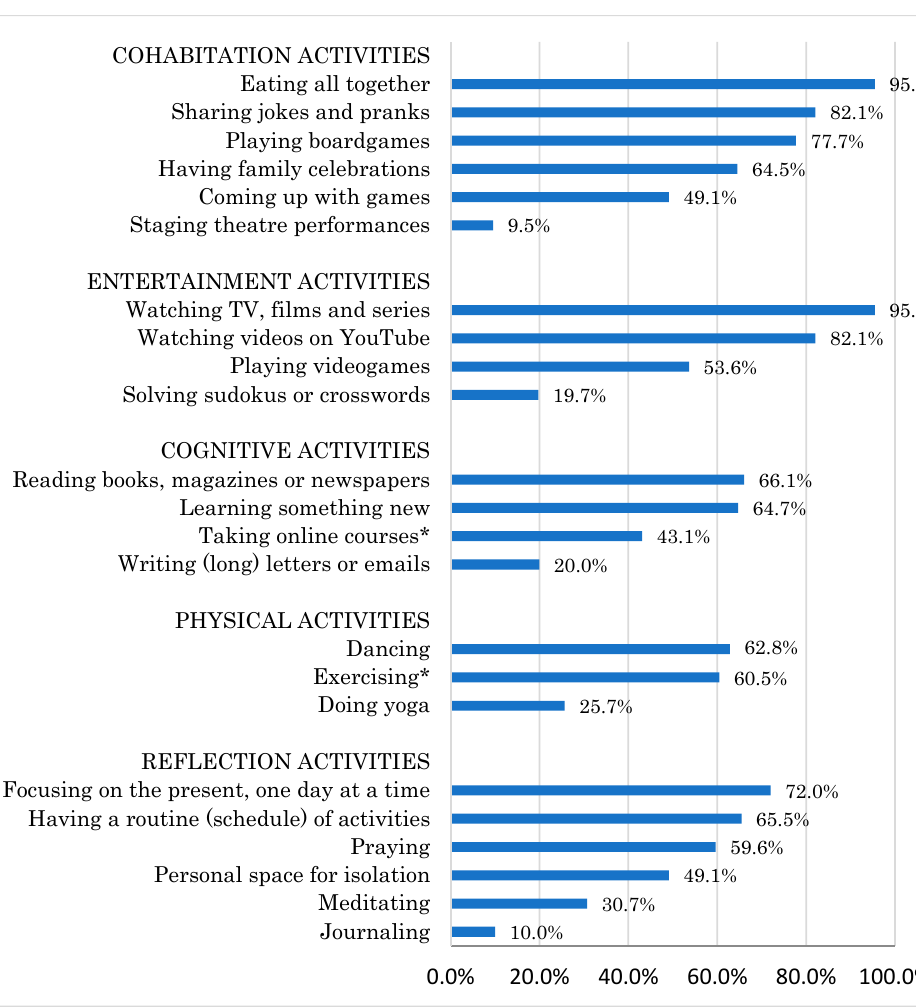
Figure 2. Coping strategies used by mothers during lockdown. Note: * Significant differences between participants with and without paid work, p < 0.05.